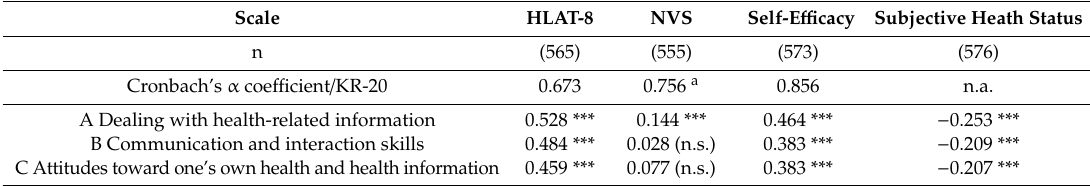
Table 5. Results of the validity (correlation) analysis for scales A–C ( n =